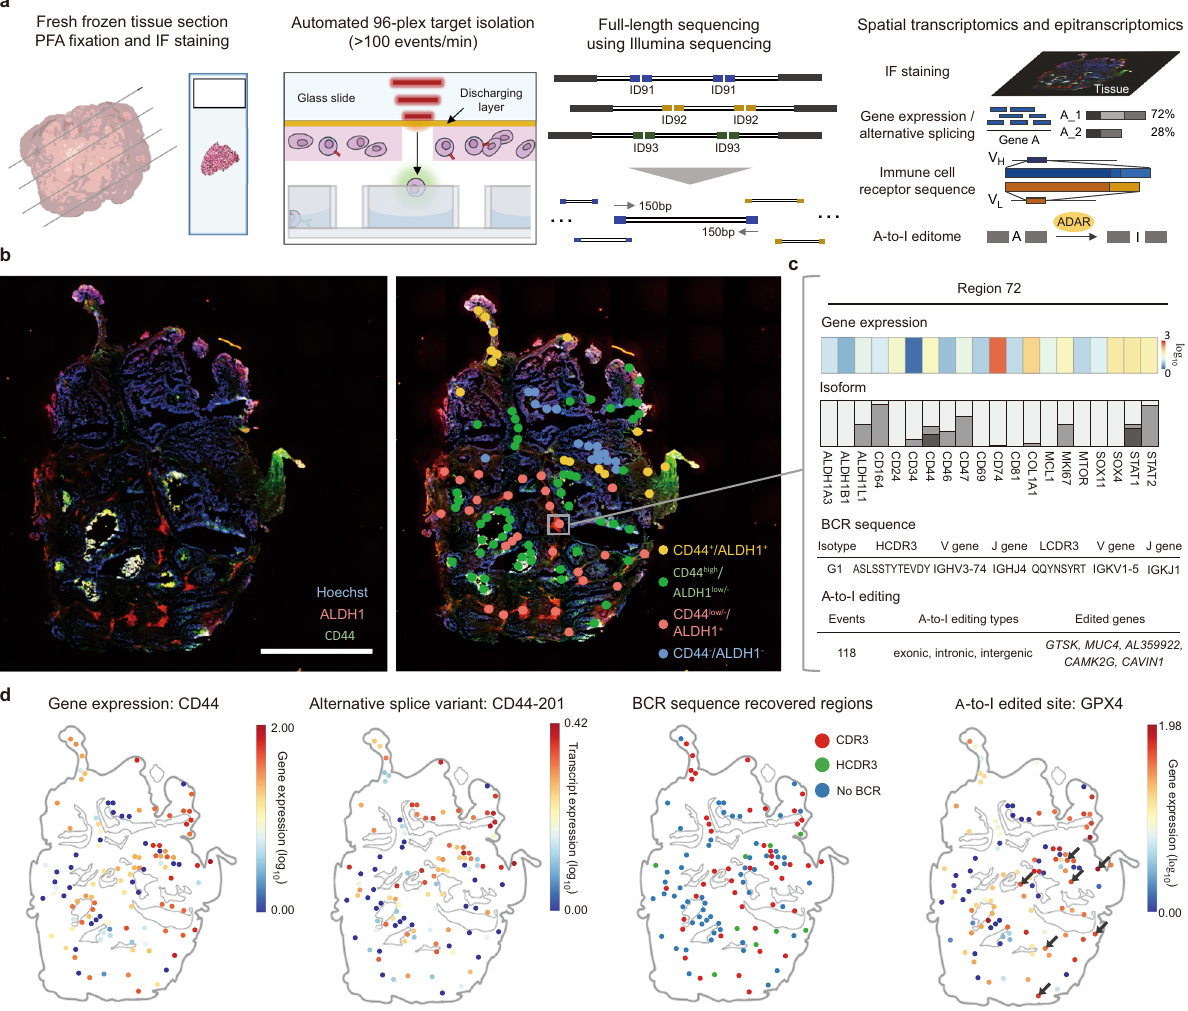
Fig. 1 Spatial-histopathological examination-linked epitranscriptomics converged to transcriptomics with sequencing (Select-seq) enables full-length spatial transcriptomics and epitranscriptomics at single-nucleotide resolution. a Schematic of the Select-seq protocol. Selective isolation of target regions in tumour sections was performed using a near-infrared pulsed laser following immuno fl uorescence staining. Full-length transcripts extracted from each targeted region are tagged with barcodes used for tracking the target region. Multi-modal analysis of the full-length transcriptome is connected with the spatial and staining information using barcodes included in the sequencing data. b Targets selected from a triple-negative breast cancer (TNBC) patient tumour section. The tissue was stained with Hoechst dye and anti-ALDH1 and CD44 antibodies (scale bar, 100 μ m). We obtained the above results from a single tissue section. c Transcriptomics and epitranscriptomics of target region 72 containing 5 – 30 cells at single-nucleotide resolution and its gene expression pro fi les, transcript isoforms, B cell receptor sequences, and adenosine-to-inosine (A-to-I) editing events. d Each transcriptomic and epitranscriptomic data point was mapped to the tissue based on the